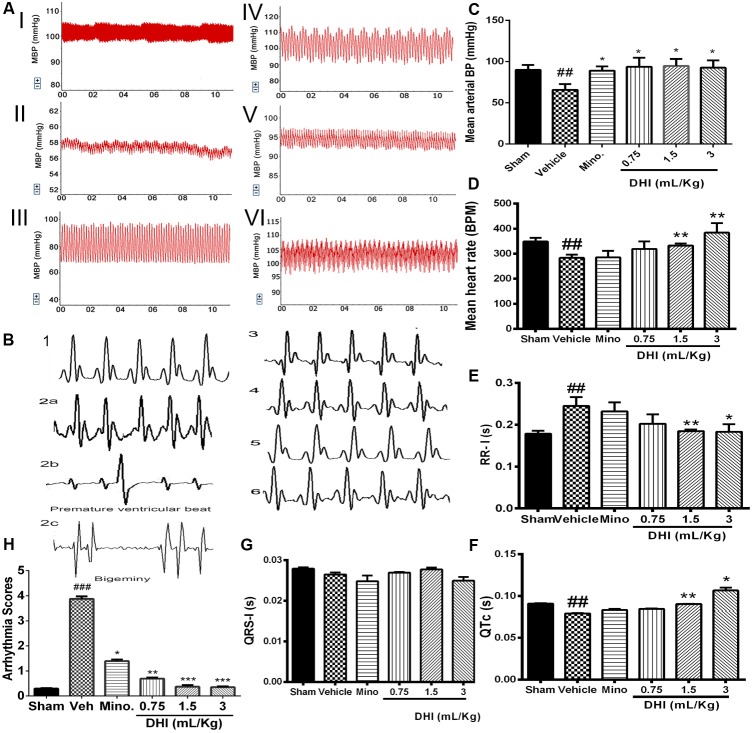
Danhong injection ameliorated CI/RI-induced cardiac dysfunction. (A) Representative traces of arterial BP: sham (I), vehicle (II), minocycline (III), and DHI: low (IV), middle (V), and high dose (VI), respectively. (C) Bar graph representation of (A). CI/RI induced a low arterial BP in the vehicle (##p < 0.01 vs. sham). Doses of DHI restored normal BP (∗p < 0.05 vs. vehicle). Mean arterial BP was also normalized in the minocycline group (∗p < 0.05 vs. vehicle). (D) Bar graph representation of HR. CI/RI, induced abnormal low HR (∼270 bpm) in the vehicle compared to sham group (∼348 bpm; ##p < 0.01). DHI-middle and -high dose significantly normalized the HR (∗∗p < 0.01 vs. vehicle; D). HR remain unchanged in the low DHI and minocycline (20 mg/kg) group (P > 0.05 vs. vehicle). (B) ECG traces for sham (1), vehicle (2a), minocycline (3), and DHI groups (low, middle, and high doses, 4–6), respectively. (E–G) Bar graph representation of (B). DHI significantly restored normal ECG RR-interval (∗p < 0.05, ∗∗p < 0.01 vs. vehicle; E) without affecting the QRS-I; (G). The QTc duration decreased significantly in the vehicle group compared to the sham (##p < 0.01, F) but was brought to the baseline by the middle and high doses of DHI (∗p < 0.05, ∗∗p < 0.01 vs. vehicle; F). QTc duration in the minocycline and low DHI were not statistically different compared to the vehicle (p > 0.05; F). (H) Bar graph quantification of arrhythmia (2b,c). CI/RI induced cardiac arrhythmia in Wistar rats (score ###p < 0.001 vs. sham). There was a premature ventricular beat and bigeminy in the vehicle group (###p < 0.001 vs. sham; 2b,c) coupled with prolongation of the ECG RR-I waves (###p < 0.01 vs. sham; E) as signs of arrhythmia but were normalized by treatment with doses of DHI (∗∗p < 0.01, ∗∗∗p < 0.001 vs. vehicle; H) and minocycline (∗p < 0.05 vs. vehicle; H). n = 5 in each group, data are presented as mean ± SEM.